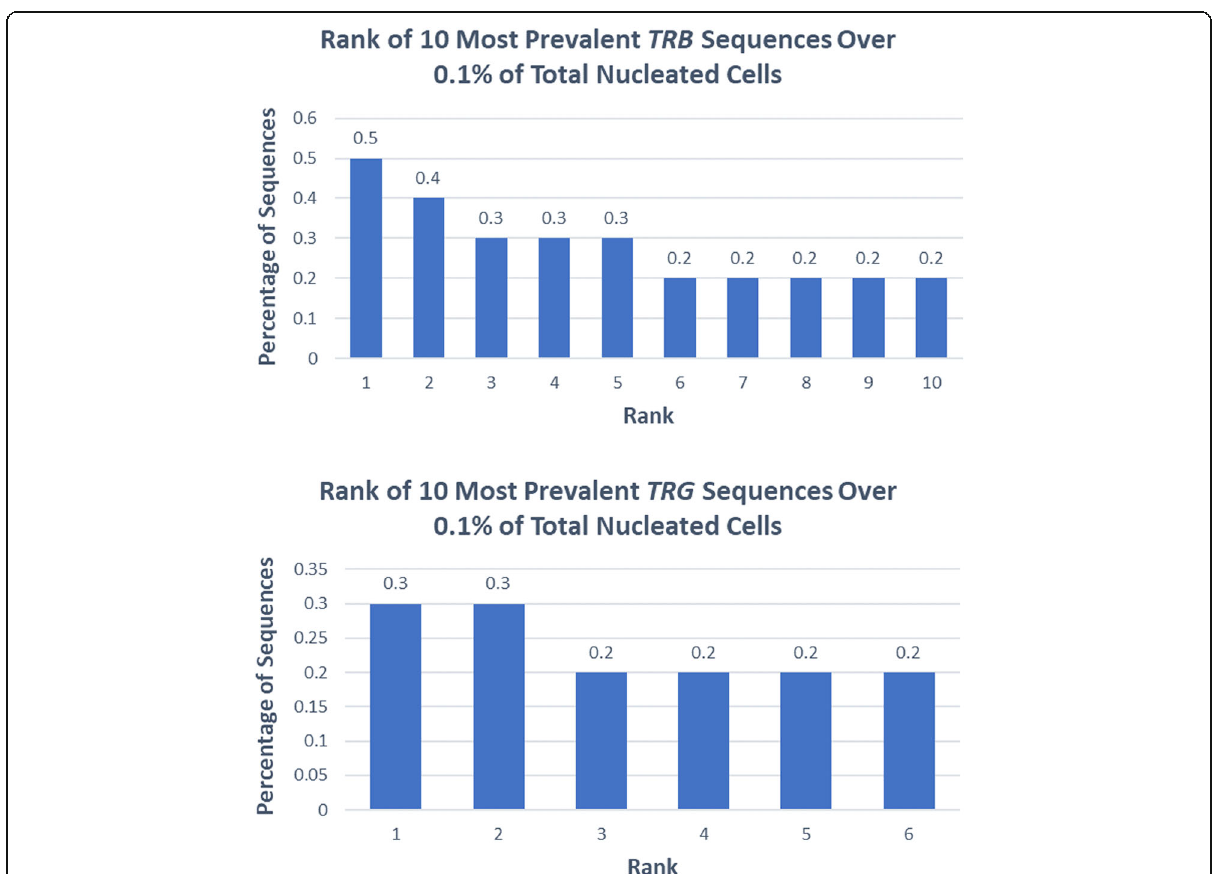
Fig. 4 Case 1. Rank of most prevalent sequences over 0.1% by next-generation sequencing of TRB (top) and TRG (bottom) for one skin